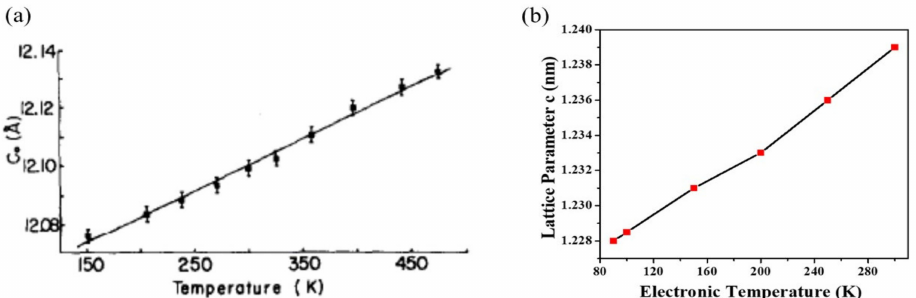
Figure 4. Thermal expansion of the c lattice constant for TaS 2 . ( a ) The experimental data are found in Reference [98]. ( b ) Relevant computational result may be found in Reference [109]. The linear trend seen in the experimental findings is well reproduced in the DFT modeling by using only the electronic temperature. Reprinted figure with permission from Reference [109]. Copyright 2019 by the American Physical